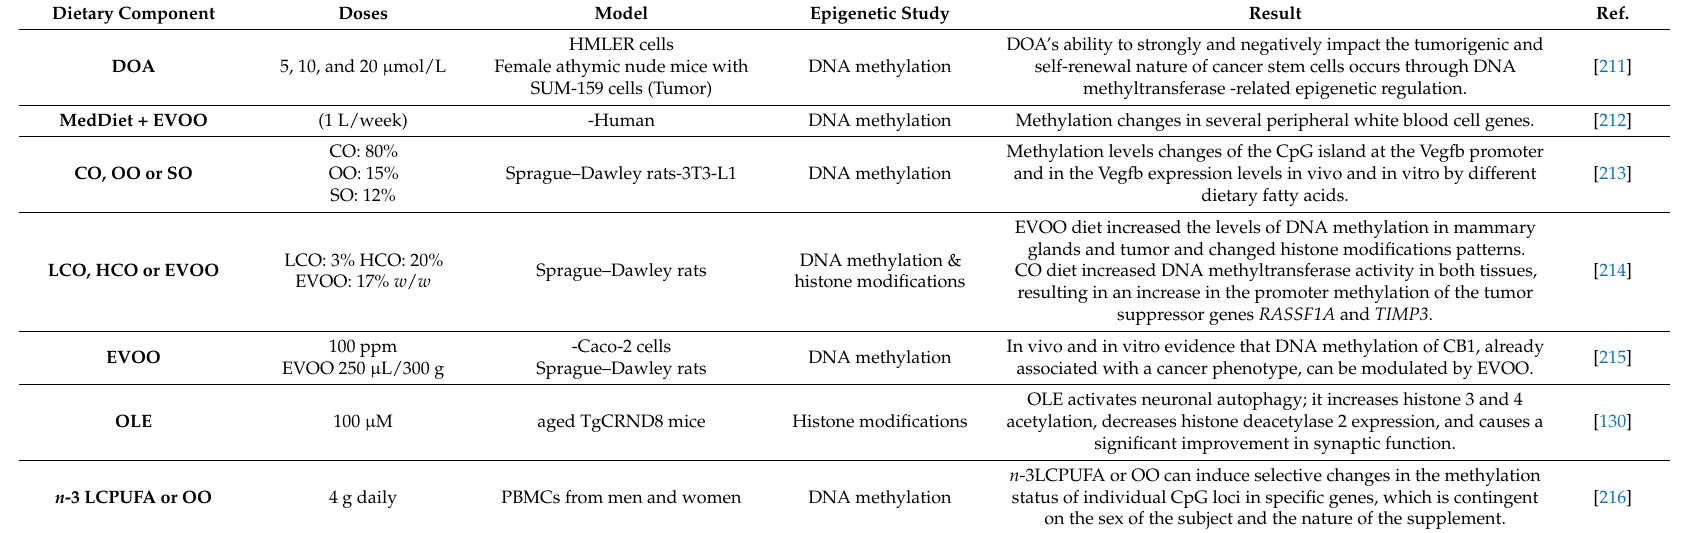
Table 2. Epigenetic studies on olive oil and its